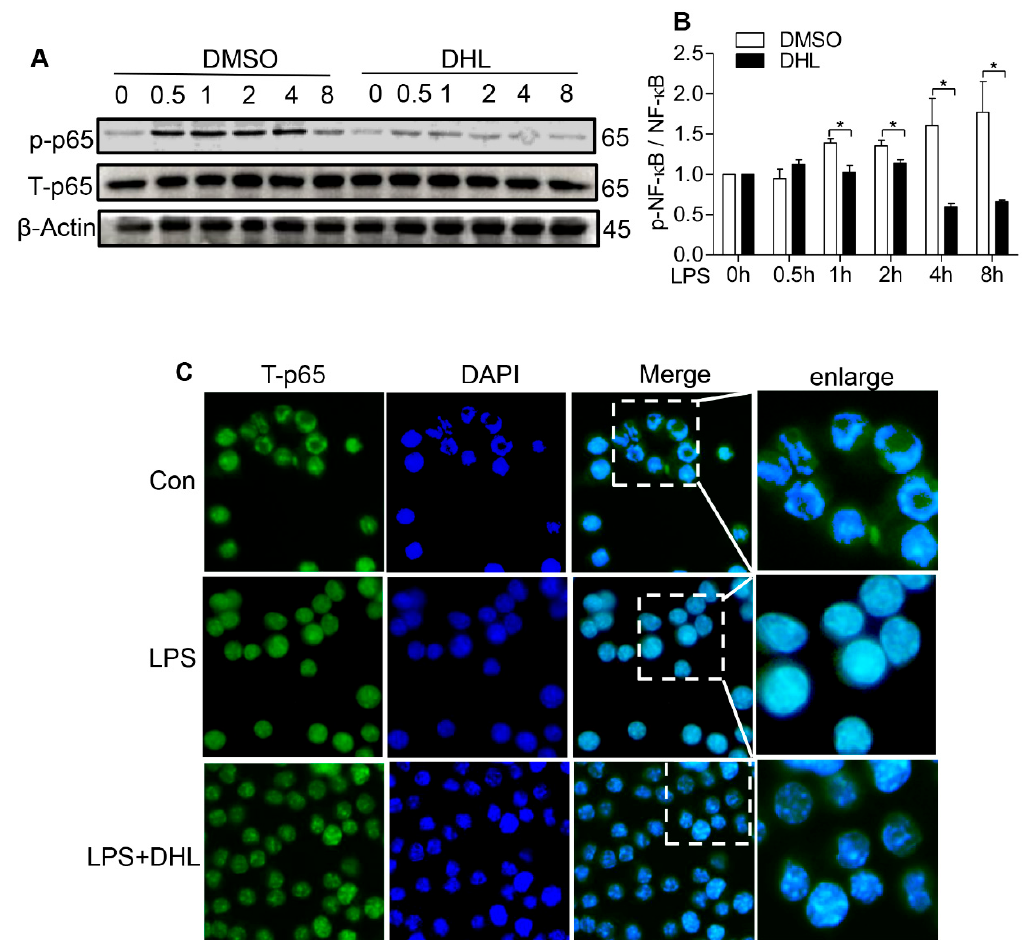
Figure 5. DHL reduced the LPS-induced NF-kB activation in RAW264.7 cells. ( A ) RAW264.7 cells were pre-treated with or without DHL (5 µ M) for 0.5 h before LPS stimulation (100 ng / mL) for 0, 0.5, 1, 2, 4 and 8 h. Cell lysates were analyzed by western blot. ( B ) Analysis of the ratios of phosphor-p65 (p-p65) and total-p65 (t-p65) was performed using Image J software. ( C ) RAW264.7 cells were pre-incubated with 5 µ M DHL for 0.5 h before challenged with LPS (100 ng / mL) for 0.5 h. Translocation of the p65 subunit of NF-kB (Green) and nuclei (blue) were detected by immunofluorescence assay as described in Materials and Methods. Data represents means ± SEM based on three independent experiments, * p < 0.05 and ** p < 0.01.